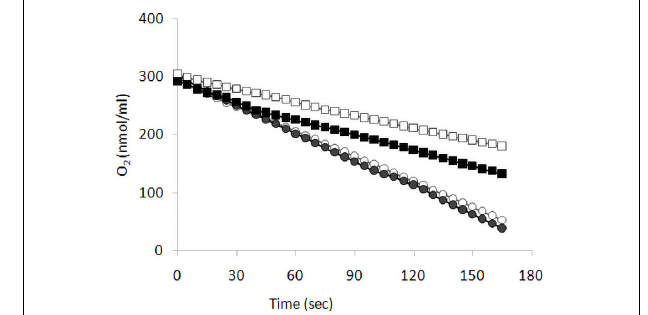
FIGURE 2 | Respiration rate. Respiration was determined as oxygen consumption rate (oxygen slope: nmol O 2 ml − 1 s − 1 ) by wild type (circles) and of Klmga2 (cid:49) mutant cells (squares), grown exponentially in YPD medium. Black and white symbols refer to dark and light cultivation, respectively. Repeated experiments gave similar slopes: average values and standard deviations of the repeated experiments are reported in text.